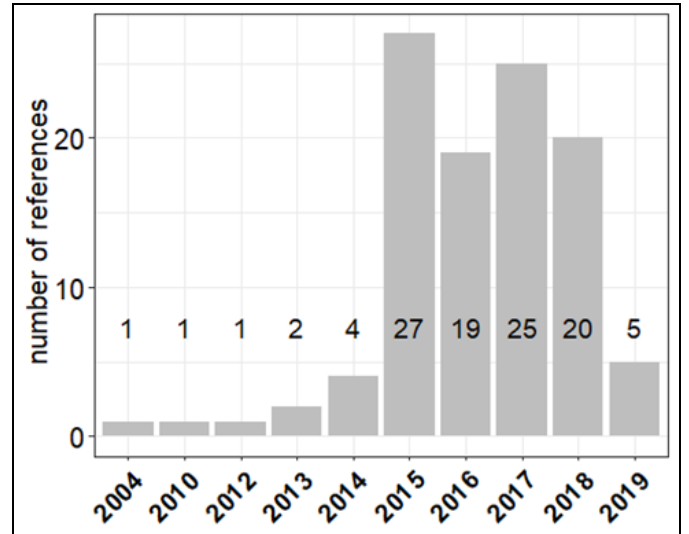
Figure 2. Number of references per year of publication that includes quantitative comparison of sensor data with reference measurements. For 2019, the number of publications covers the publications from the period between January and April.